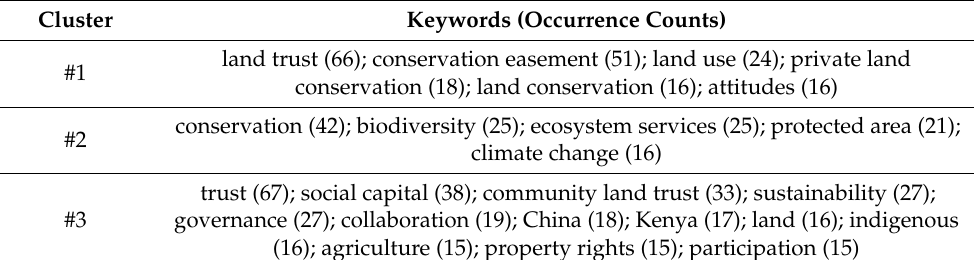
Figure 4. The keywords’ co-occurrence in the land trust field. Table 1. The keywords and co-occurrence